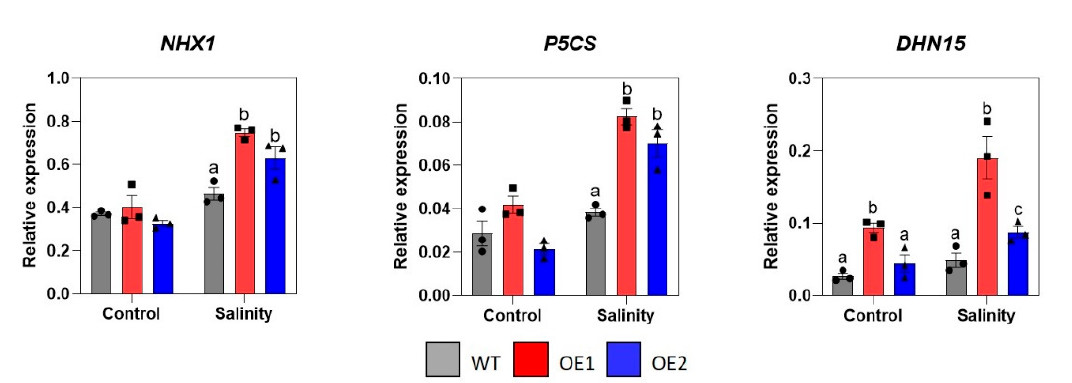
Figure 5. Expression profiles of three stress-related genes in root tissues of GmNAC085 -transgenic soybean lines (OE1 and OE2) and wild-type (WT) plants under salt stress treatments, including GmNHX1 , GmP5CS and GmDHN15 . Each value represents the mean ± SE ( n = 3). Significant differences among the genotypes in each treatment that were analyzed by ANOVA and Tukey’s honestly significant difference test were indicated by different letters ( p <